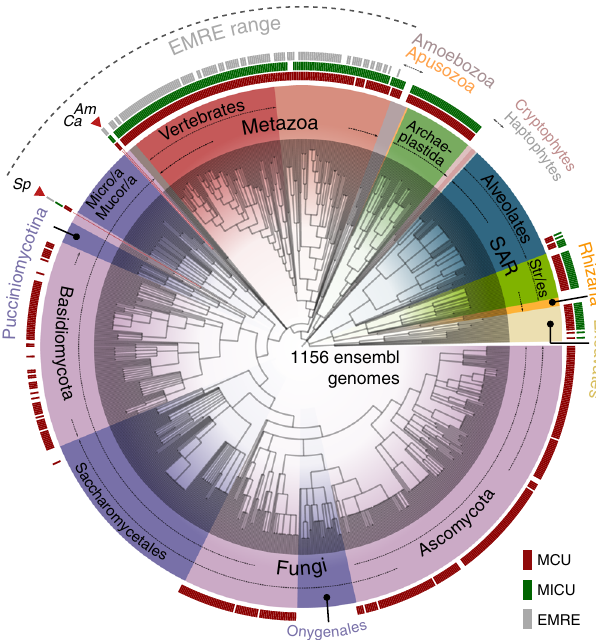
Fig. 1 Phylogenetic distribution of mt-Ca 2 + uniporter protein families. The phylogenetic distribution of MCU (red), MICU (green), and EMRE (gray) homologs across 1156 eukaryotic genomes is shown on the NCBI taxonomy tree. Viridiplantae and Rhodophyta (red algae) have been grouped together as Archaeplastida, and alveolates, stramenopiles (Str/es), and rhizarians as the SAR clade. In all cases where data from various strains of a species are present with the same pattern, these have all been collapsed to the species level, resulting in 969 terminal nodes shown. The mt-Ca 2 + uniporter complex has been completely lost in Apicomplexa within Alveolates, Rhizaria (5 genomes), red algae (3 genomes), Cryptophytes (3 genomes), Haptophytes (1 genome), and the Entamoeba clade within Amoebozoa. Within fungi (in purple), all major clades that have completely lost MCU homologs are indicated with a darker purple color, namely Onygenales, Saccharomycetales, Pucciniomycotina, Mucoromycotina (Mucor/a), and Microsporidia (Micro/a). The only three early diverging fungal species ( A. macrogynus-Am , C. anguillae-Ca , S. punctatus-Sp ) that encode also MICU and EMRE are highlighted with a red arrowhead. The NCBI taxonomy and the presence/absence pro fi le were visualized using the ETE toolkit 41 . For a version of the pro fi le, which includes the species names, see Supplementary Fig.